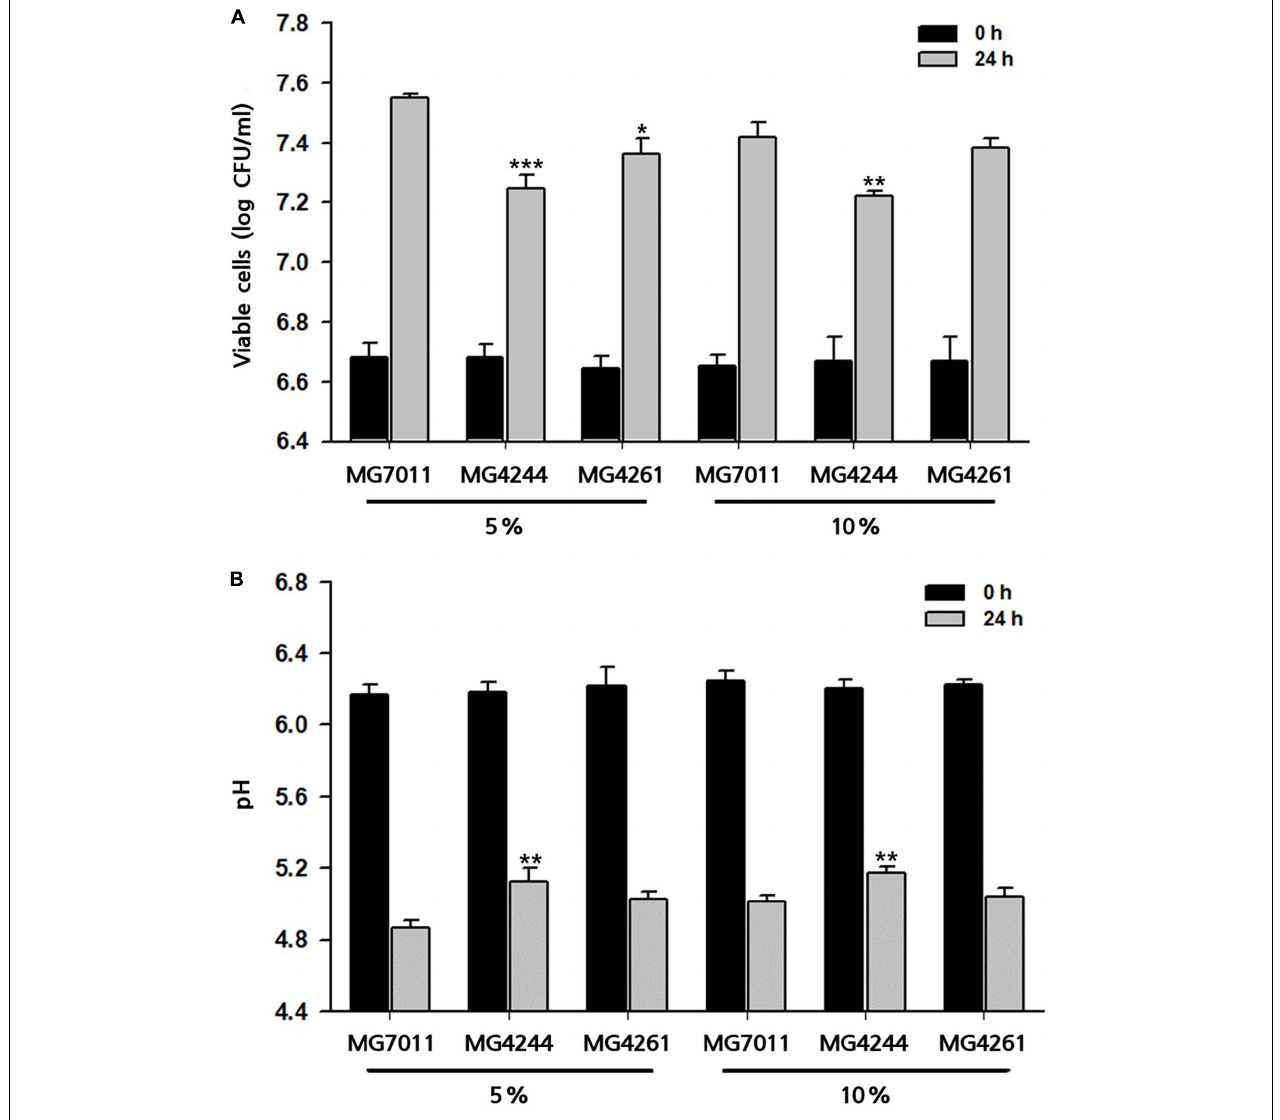
FIGURE 6 | Growth profiles of selected Limosilactobacillus fermentum strains 5% and 10% rice at 30 ◦ C for 24 h. (A) viable cells counts and (B) pH value. Results are expressed as means ± SD ( n = 3). * p < 0.05, ** p < 0.01, *** p < 0.001 compared with